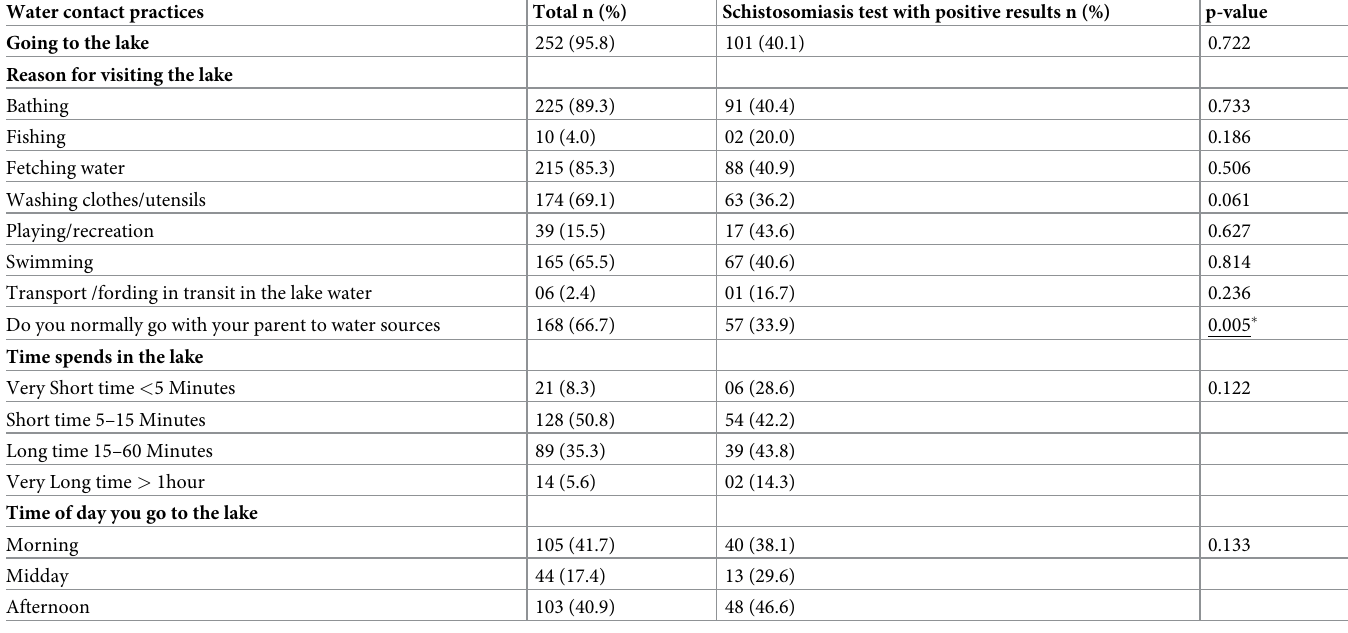
Table 4. Water contact practices of the study